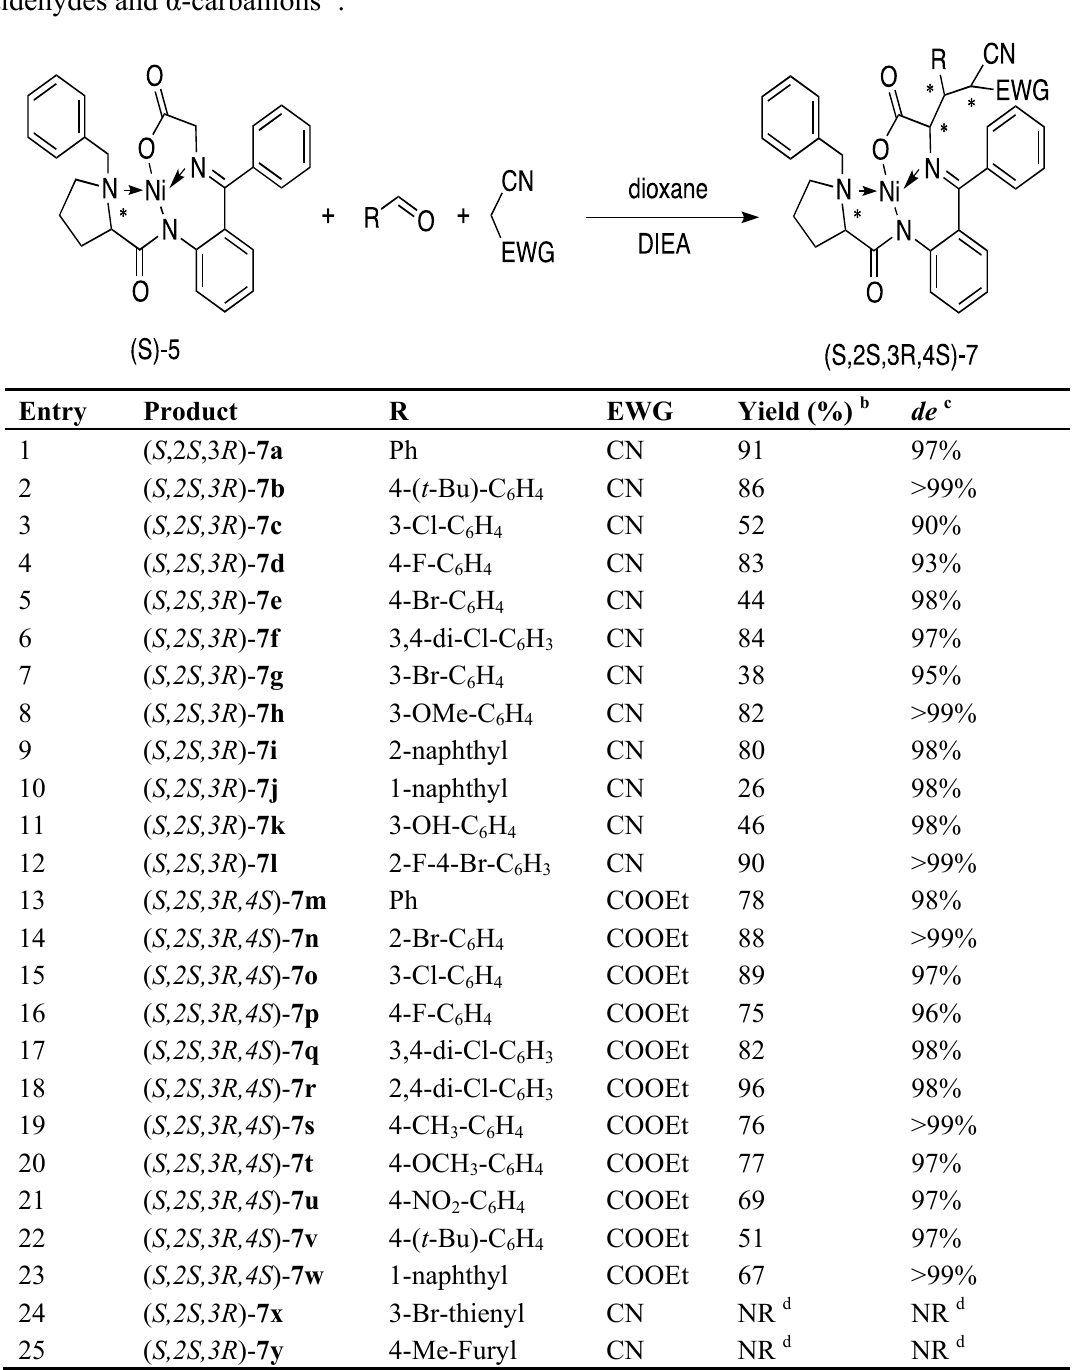
Table 2. Asymmetric Michael reactions of chiral nickel(II) glycinate ( S )-5 with aromatic aldehydes and α -carbanions a